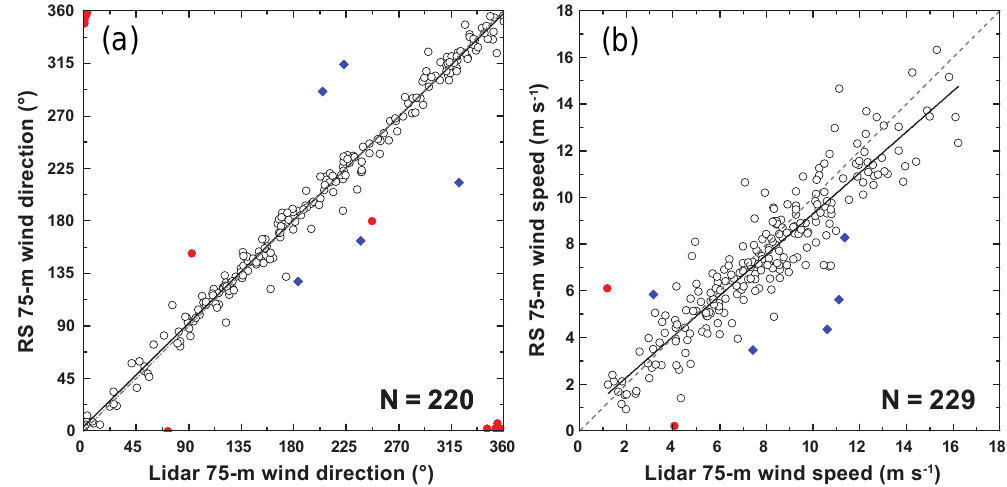
Figure 4. Doppler lidar evaluation: the sinusoidal fit solution is compared to data from radiosondes launched every 6h from Oden for (a) wind direction and (b) wind speed. Number of points and linear fit parameters are given in Table 2; red points indicate outliers in wind direction. The blue diamonds show comparison points obtained when the stabilisation platform was turned off. Table 2. Statistics of the comparison between lidar and radio sounding for a height of 75m. Normalised RMSE is defined as RMSE divided by the maximum range of the measured values